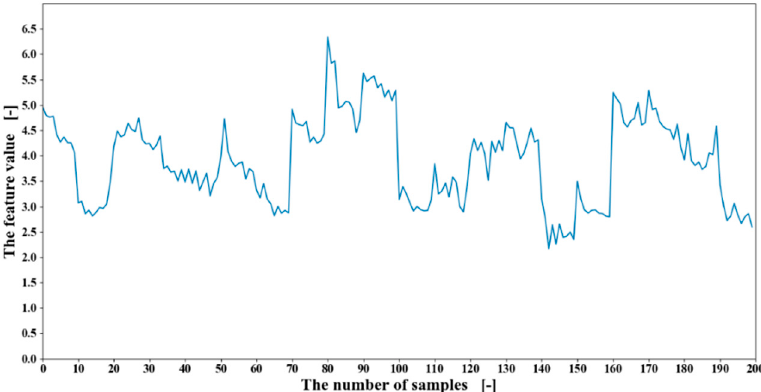
Figure 11. The root mean square (RMS) feature value of one channel from obtained EMG data of participant one.